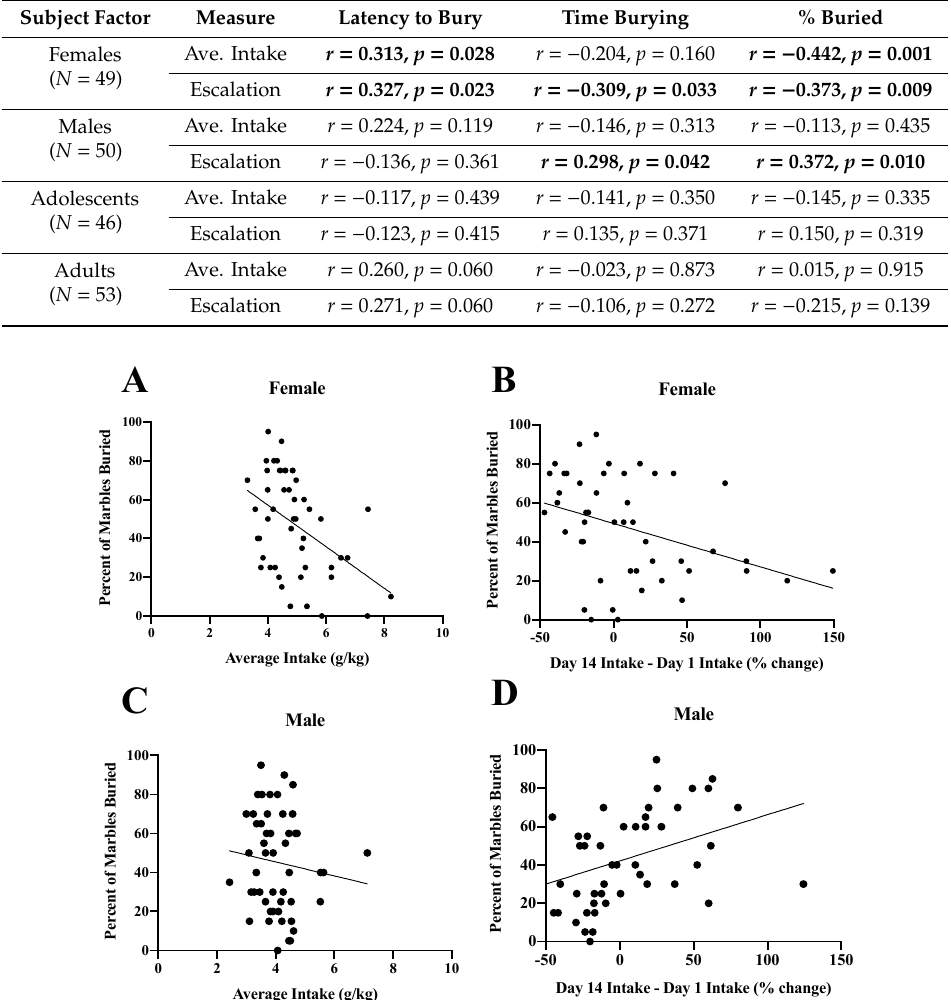
Figure 15. Summary of the inter-relations between the average alcohol intake (left), the escalation of alcohol intake (right) and the percent marble buried in the marble-burying test. In female mice, an inverse relationship was observed between both ( A ) alcohol intake and ( B ) the escalation of alcohol intake and the percent of marbles buried. ( C ) In male mice, no significant correlation was observed between the average alcohol intake and the percent of marbles buried. ( D ) However, an escalation of drinking predicted the percent of marbles buried in males.